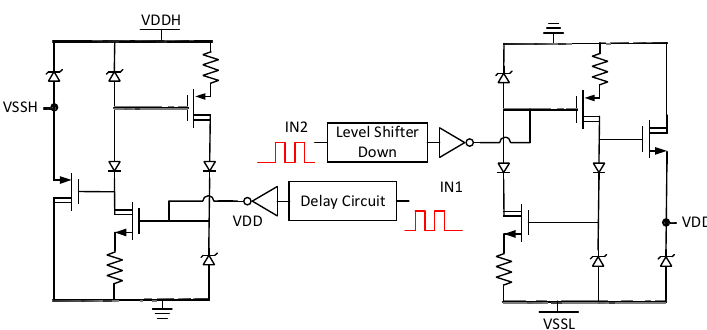
Figure 9. Floating power supply schematic and its controller.